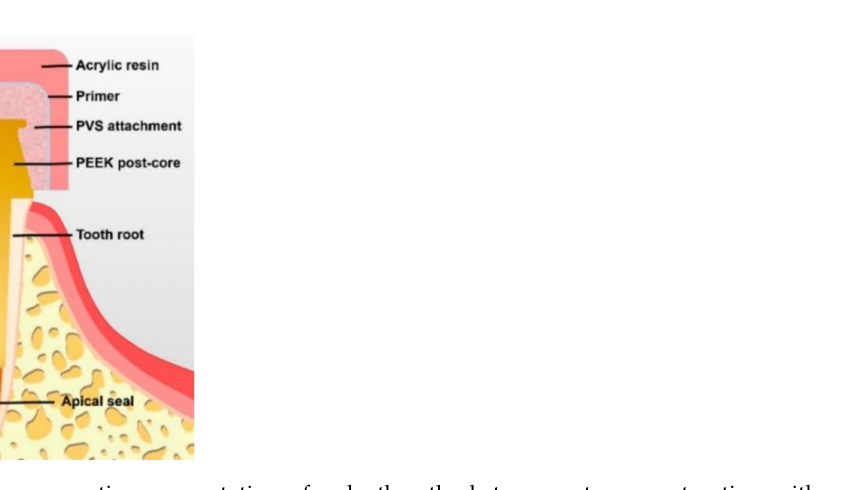
Figure 5. Diagrammatic representation of polyetheretherketone post-core restoration with a polyvinylsiloxane attachment system